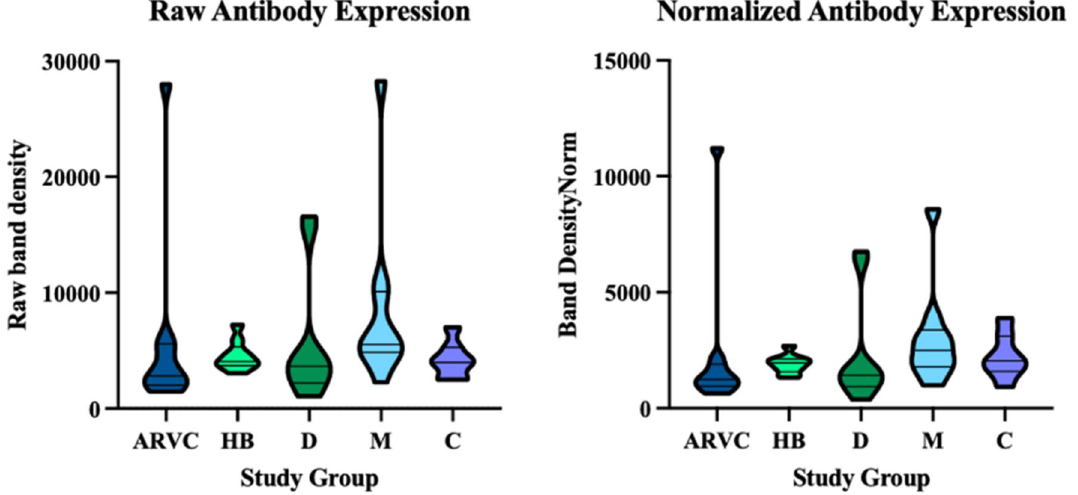
Figure 3. Violin plots displaying the raw and normalized anti-desmoglein-2 antibody densities by group. The width of each plot is proportionate to the number of points at that density. The top line within each plot represents the first quartile range, the middle line represents the median, and the bottom line represents the first quartile range. ARVC ARVC Boxer dogs, HB healthy Boxer dogs, D Doberman Pinschers with DCM, M small dogs with MMVD, C healthy non-Boxer